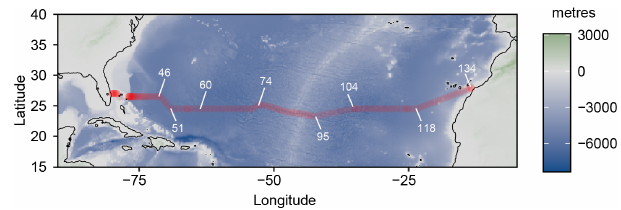
Figure 1. Cruise track of the JC191 24N expedition from Fort Laud- erdale (Florida), USA, to Santa Cruz de Tenerife, Spain (January– March 2020). White numbers indicate some of the total 135 CTD